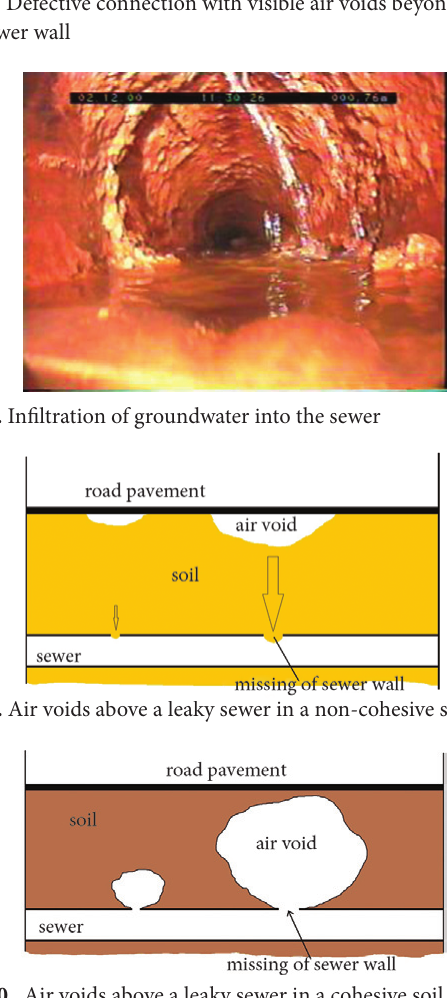
Fig. 10. Air voids above a leaky sewer in a cohesive